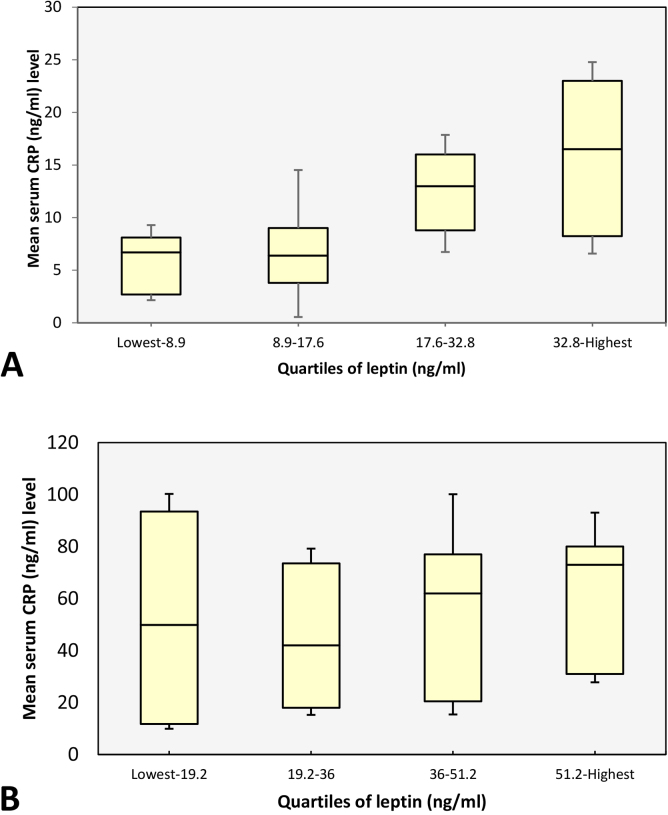
Modified boxplot with error-bars, showing CRP levels in quartiles of leptin. Boxes represent interquartile range (Q1-Q3) and whiskers show error-bars, demonstrating the range of mean ± SD. (A) controls, (B) RA patients. CRP levels are higher in upper leptin quartiles and lower in lower leptin quartiles of healthy control. RA patients do not show such a phenomenon.